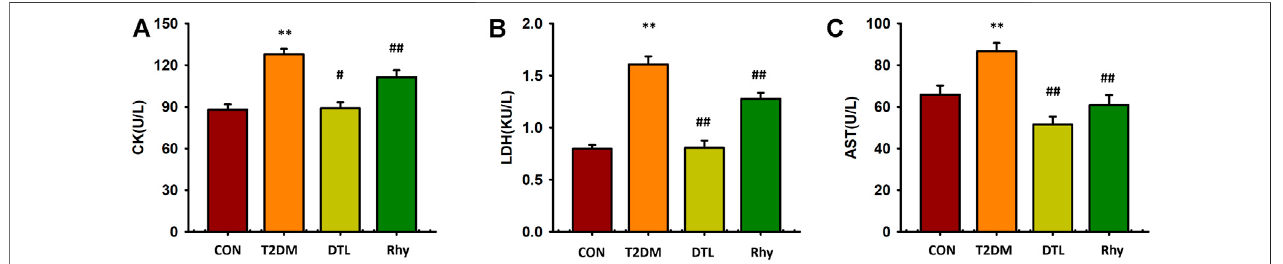
FIGURE 5 | Effect of rhynchophylline on cardiac enzymes. (A) The levels of creatine kinase (CK). (B) The levels of lactate dehydrogenase (LDH). (C) The levels of aspartate aminotransferase (AST). Values are presented as mean ± standard error of the mean. ** p < 0.01 vs. control group; # p < 0.05, ## p < 0.01 vs. type 2 diabetes mellitus